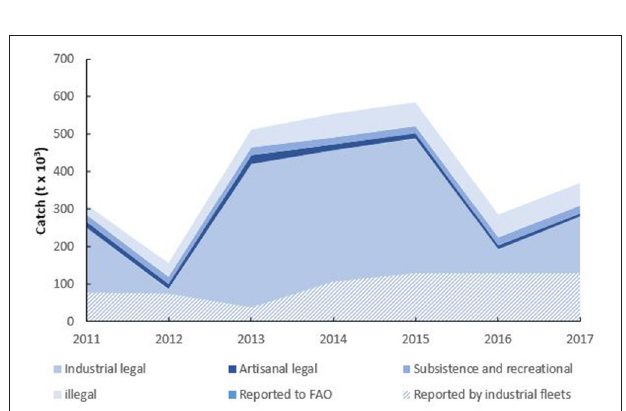
FIGURE 5 | Reconstructed artisanal catches in Guinea-Bissau, 2010–2015.